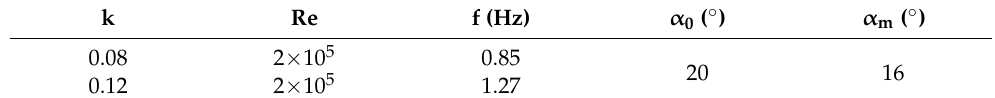
Table 10. Experimental conditions for changing the reduced frequency.